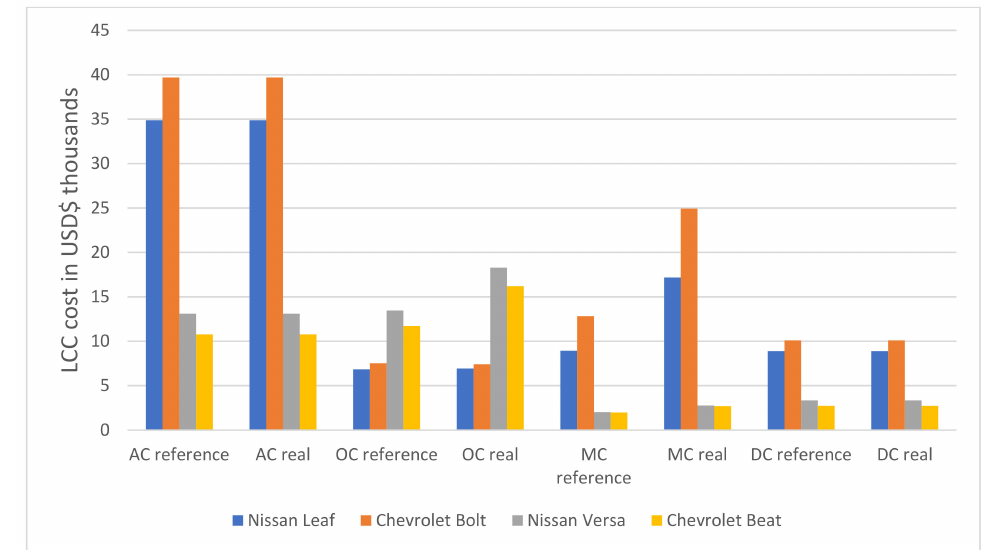
Figure 2. LCC comparison of the chosen vehicles with the real distance vs. the reference distance. The different contributions of the operation and maintenance costs to the LCC when the real annual average distance travelled was considered versus the annual average distance (set as a reference) are depicted in Figure